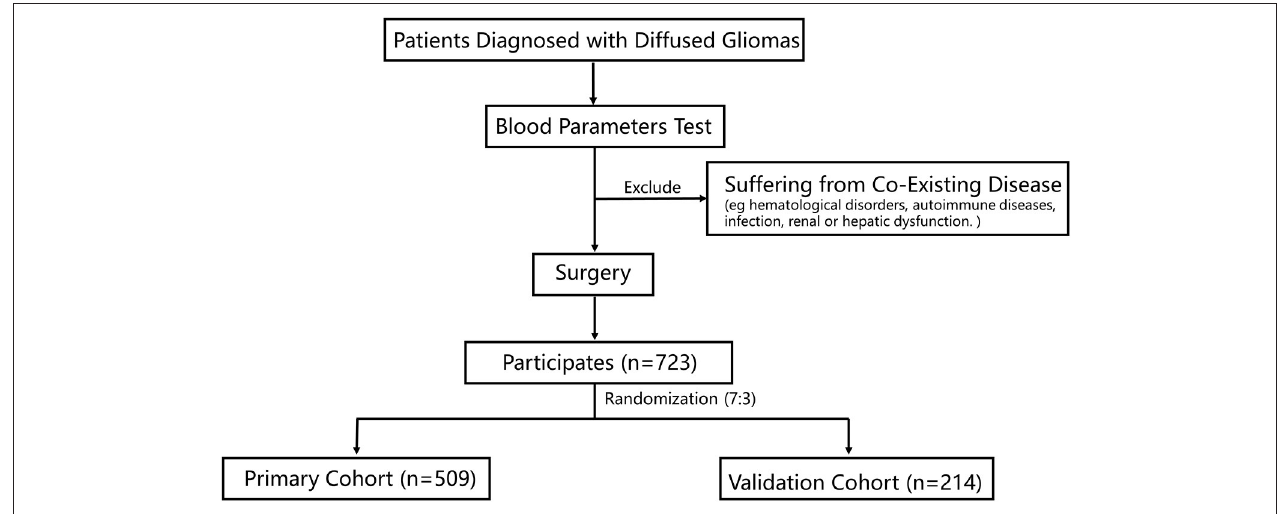
FIGURE 1 | A flow chart of the process of patient selection.